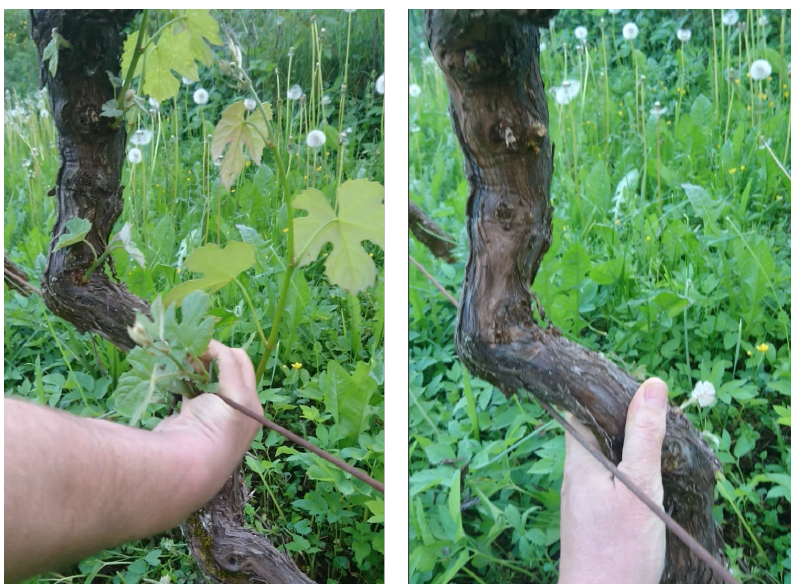
Figure 1. Manual suckering process is shown on the left. Usually, while performing manual suckering, the worker also removes the excess bark from the trunk of the plant, as shown on the right.